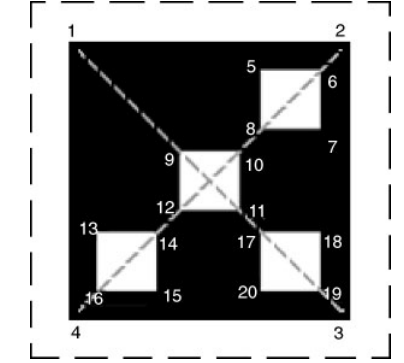
Figure 2 Pattern of target and order of